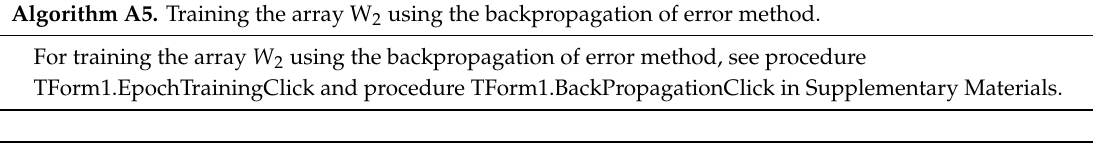
Algorithm A6. Testing the